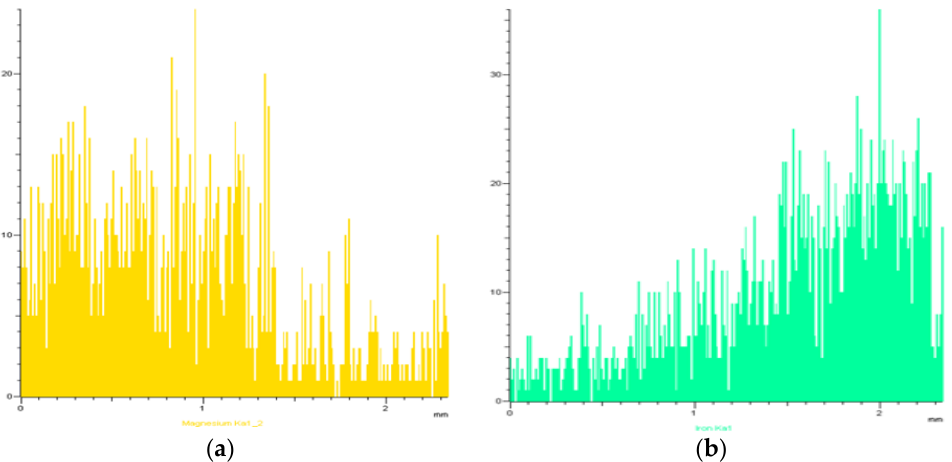
Figure 5. Linear mapping of Mg ( a ) and Fe ( b ) along a line vertical to the slag – refractory interface (experiment at temperature 1700 ◦ C, contact time 2 h).